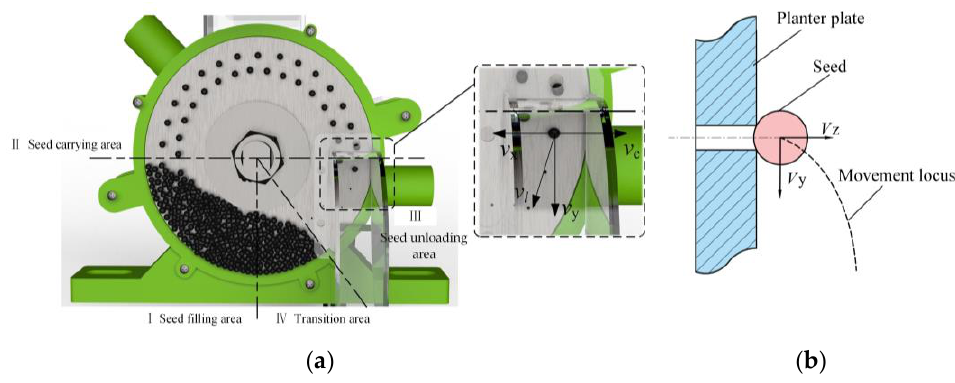
Figure 8. Analysis of the processes seed arrangement. ( a ) Kinematics analysis in the xy plane; ( b ) Kinematics analysis in the yz